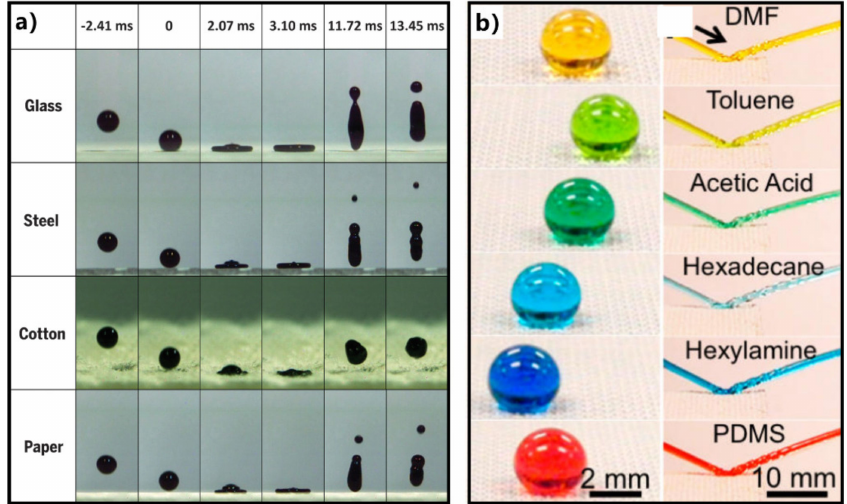
Figure 10. ( a ) Re-bounce of the water droplets on different superhydrophobic-coated substrates. ( b ) Jets of different Newtonian liquids rebounding on the superamphiphobic mesh. Reprinted with permission from ref. [204]. Copyright 2015, The American Association for the Advancement of Science. Reprinted with permission from ref. [205]. Copyright 2013, American Chemical